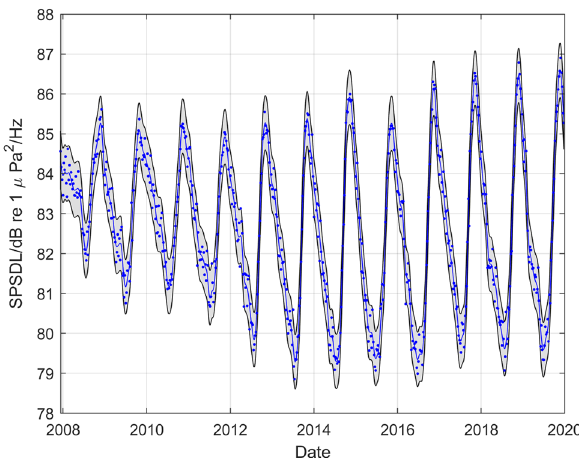
Figure 2. GP regression for the northern triplet hydrophone H11N1 data recorded at the CTBT Wake Island station for the frequency band 10–40 Hz, a weekly aggregation period and the statistical level P 10